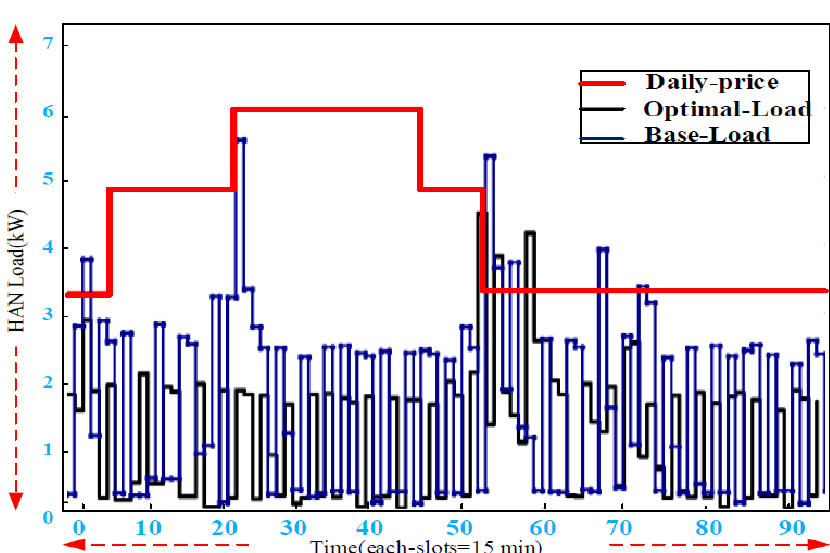
Figure 17. Total HAEMS load after and before optimization.